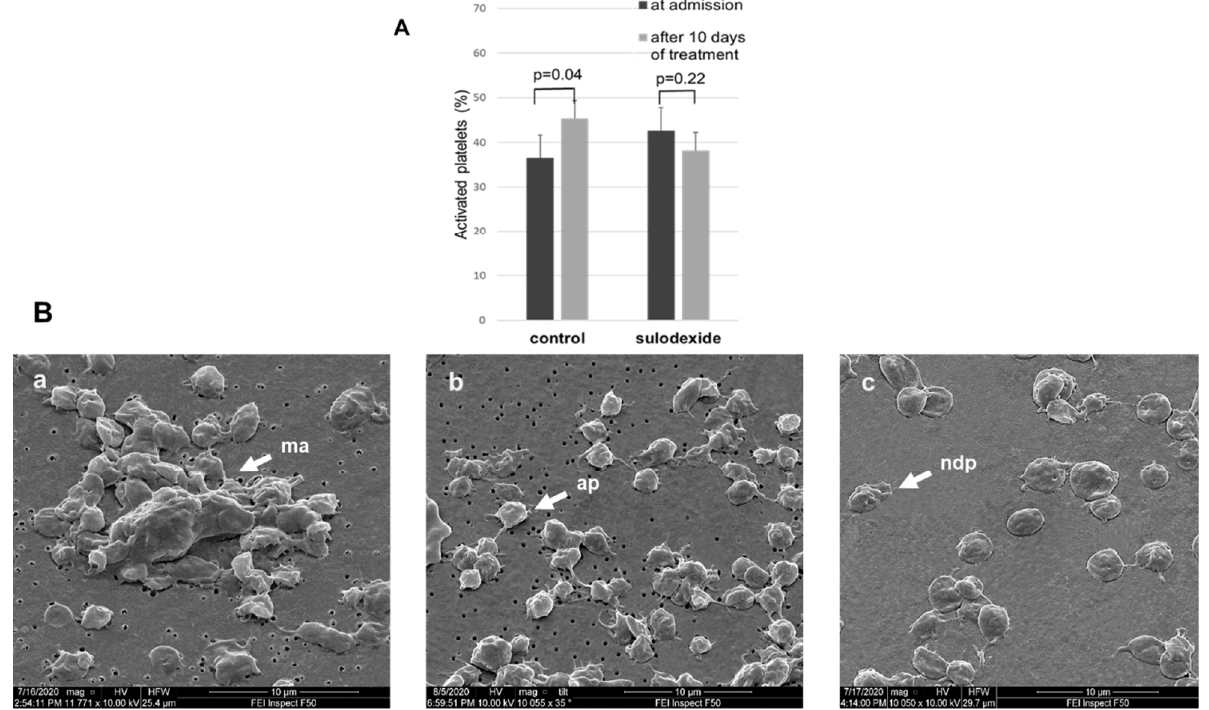
Figure 3. ( A ): Effect of routine treatment and treatment including sulodexide on the share of activated platelets in venous blood of patients with COVID-19. ( B ): Microphotographs of blood specimens on admission ( a ) and after 10 days of treatment in control ( b ) and experimental ( c ) groups. Arrows indicate ma—microaggregates; ap—activated platelets; ndp—normal discoid platelets. Magnification ×10,000.